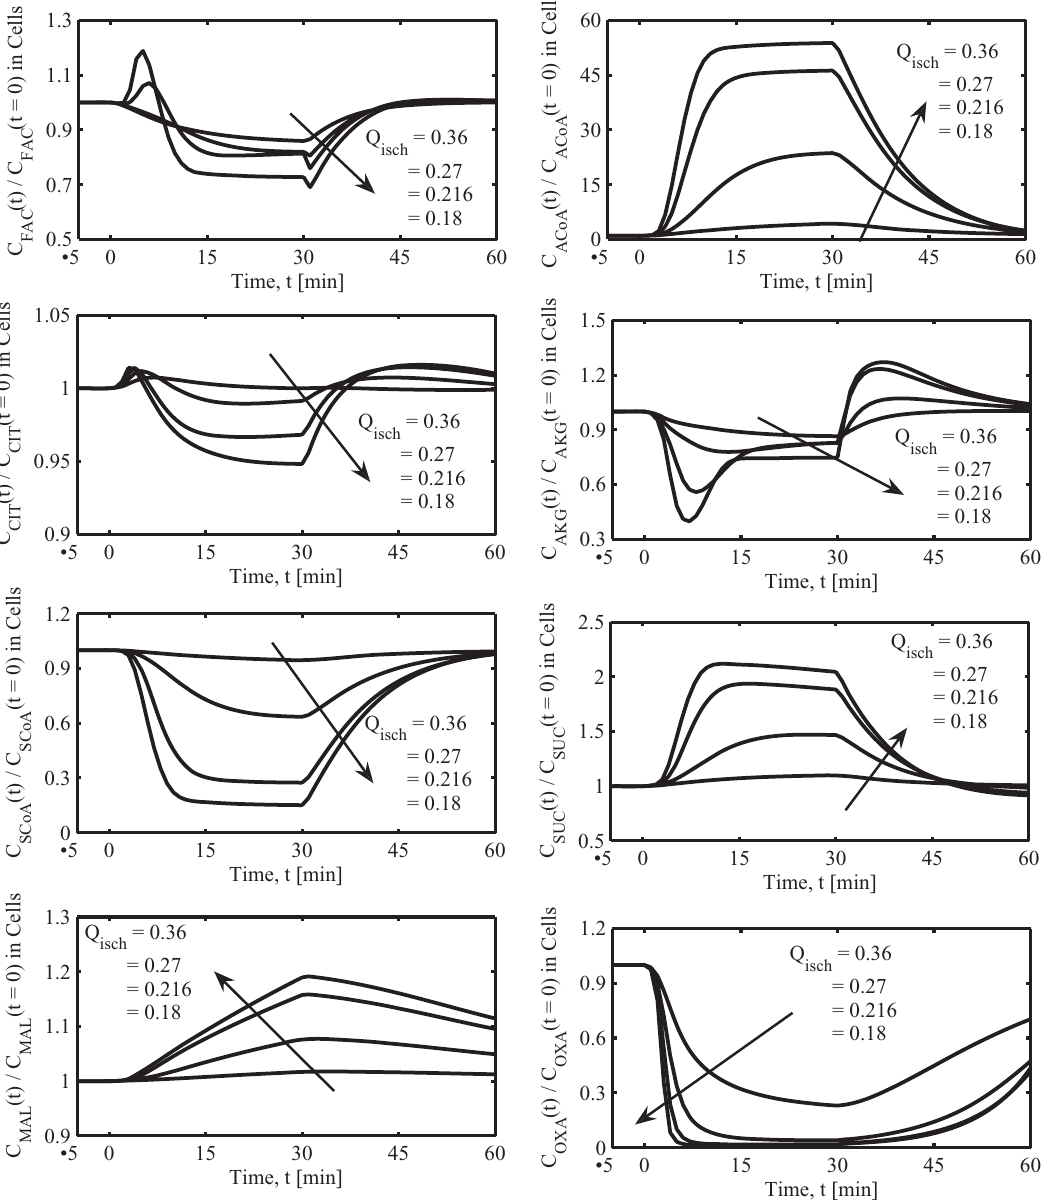
Figure 6. Model-predicted dynamic responses of FAC, ACoA, and TCA cycle intermediate concentrations in the muscle tissue cells mitochondria during the resting, ischemia and recovery periods with varying levels of blood flow reduction. The simulation strategy, ischemia protocol, and blood flow reduction levels are exactly the same as those described in the caption of Figure 3. The metabolites concentrations are shown in normalized form, normalized with respect to the resting metabolites concentrations. The concentrations in the tissue cells were calculated based on the formula: C cl =( V cyt C cyt + V mit C mit )/ V cl .